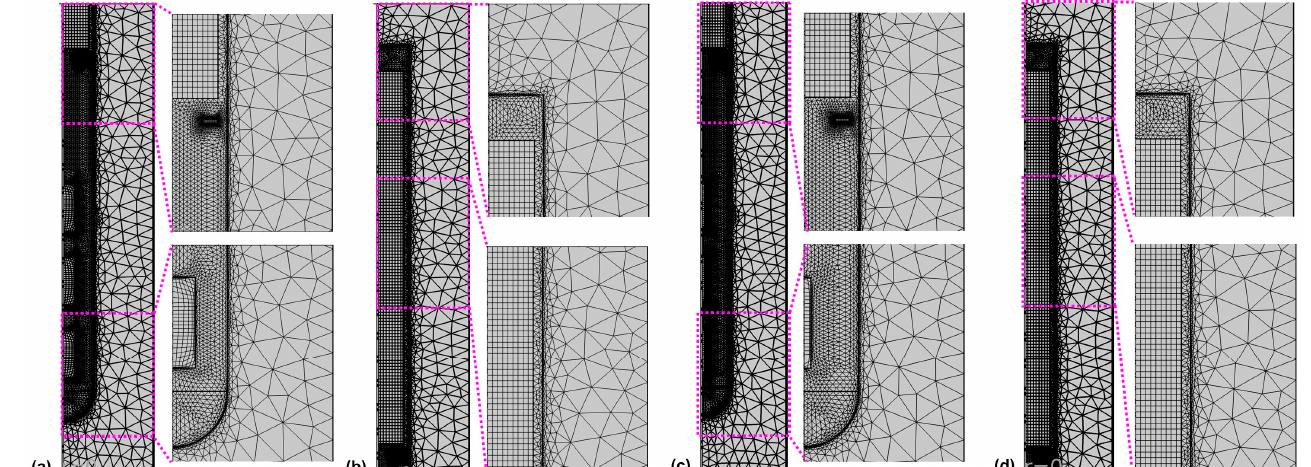
Figure 4. Mesh in ( a ) and ( c ) the lower and ( b ) and ( d ) the upper part of the autoclave for the model versions with thick seeds ( a , b ) and thin seeds ( c , d ).